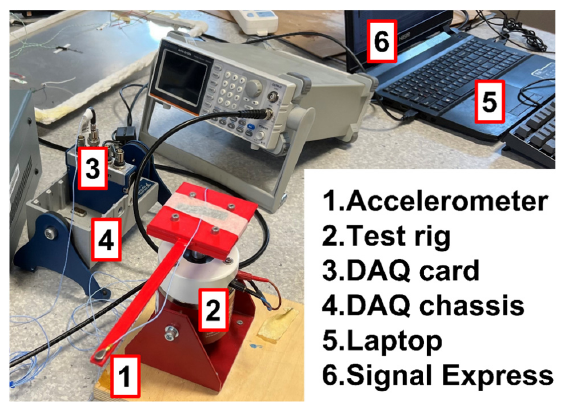
Figure 3. Experimental setups.